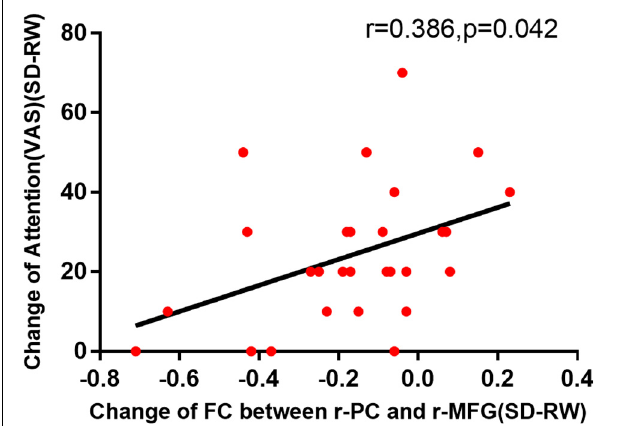
FIGURE 3 | The change in functional connectivity was significantly correlated with the VAS of attention. VAS, Visual Analog Scale; SD, sleep deprivation; RW, rested